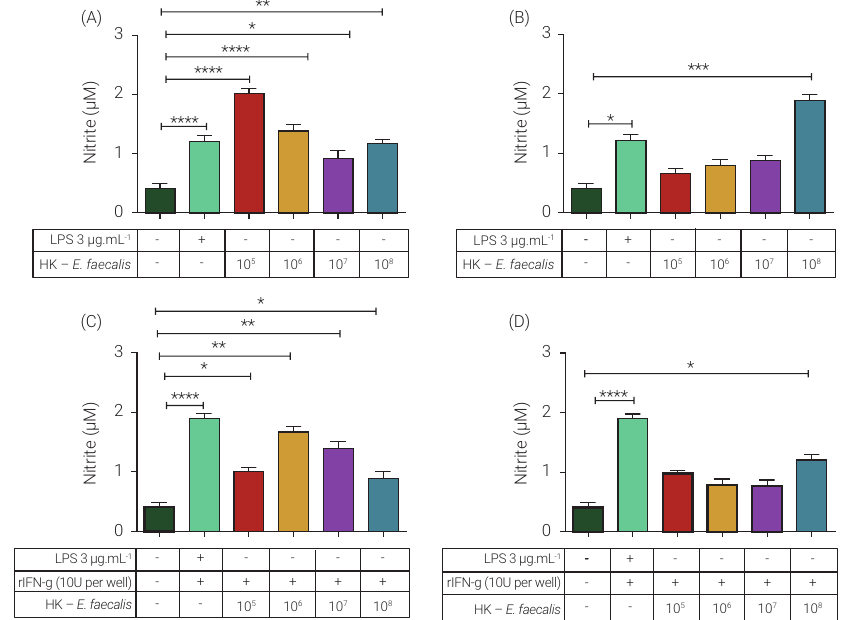
Figure 4. NO production by L929 fibroblasts. Graphs represent values of sodium nitrite with different concentrations (10 5 -10 8 CFU.mL -1 ) of HK- S. aureus antigen (A) with rIFN-γ (C) or HK- E. faecalis antigen (B) with rIFN-γ (D), after 72h of cell incubation. Bars represent mean and standard error of sodium nitrite production in µM carried out in technical and biologic triplicates. Statistical differences by one-way ANOVA test and Bonferroni post hoc (p<0.05) were represented by * (p < 0.05), ** (p < 0.01) *** (p< 0.001) and **** (p <